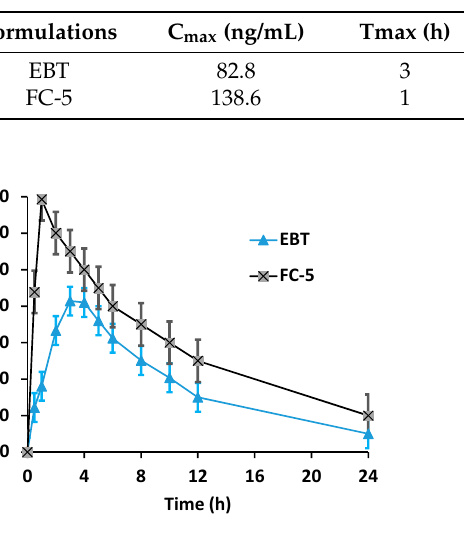
Figure 10. Mean plasma concentration-time curve of pure EBT and FC-5 orodispersible film after oral administration in rat ( n =